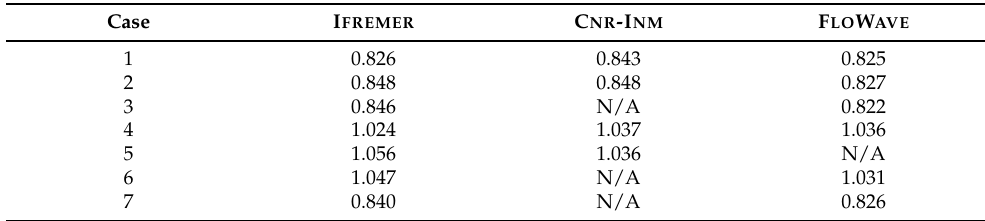
Table 5. Disc-integrated velocity average (DIVA) values for the flow characterisation without turbine for all cases at all facilities. See Section 2.5.1, from